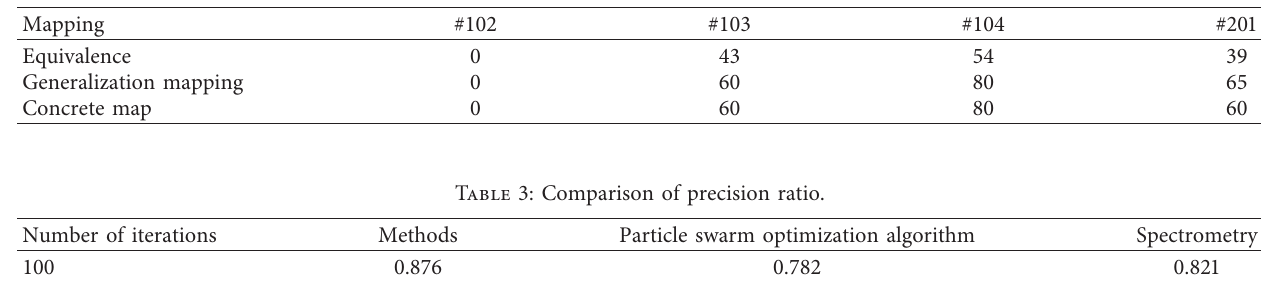
Table 2: Semantic mapping results between